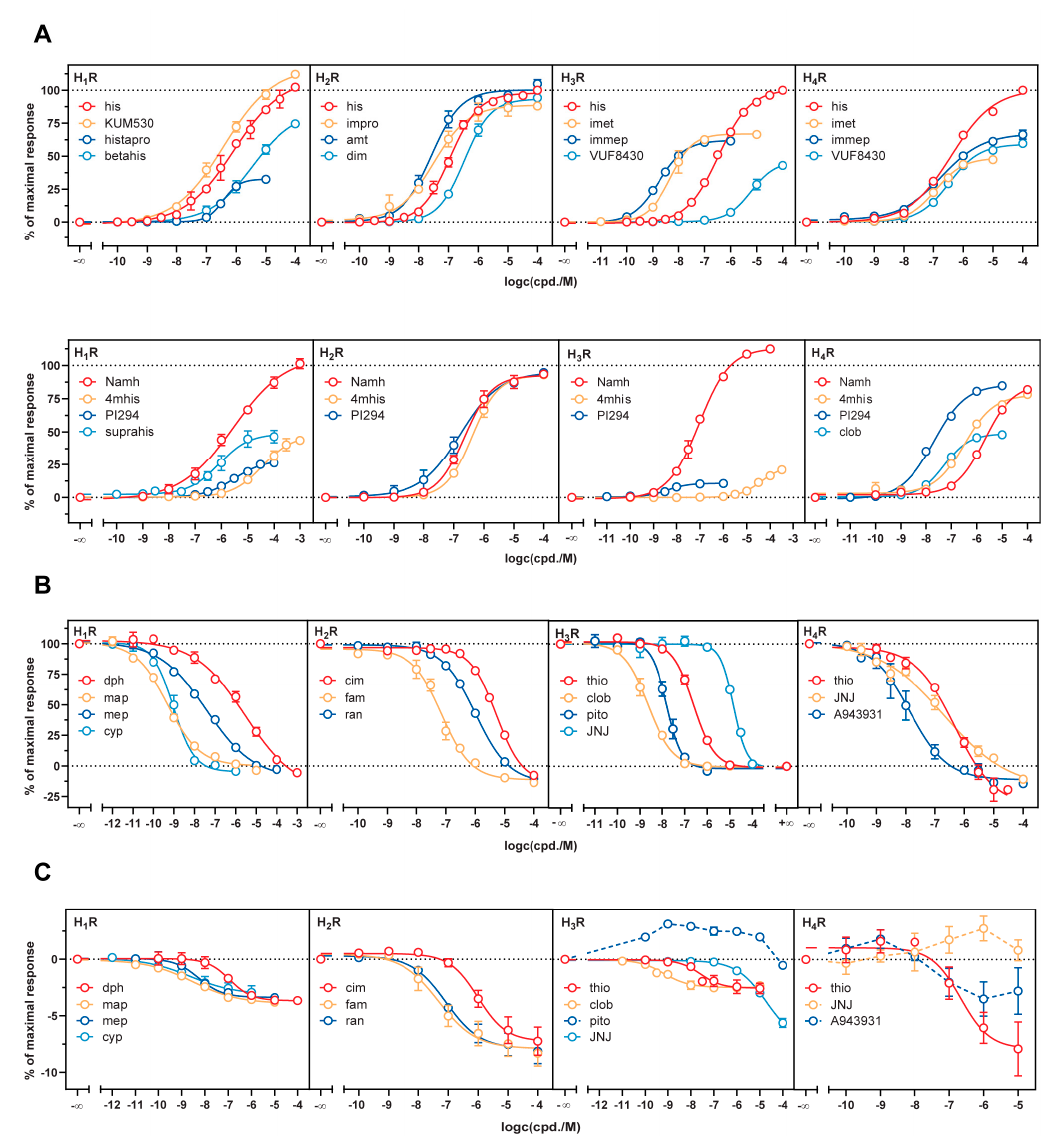
Figure 2. Concentration response curves obtained in the mini-G protein recruitment assay using agonists ( A ) in agonist mode, as well as antagonists in antagonist mode ( B ) and agonist mode ( C ). In agonist mode, the effect of the ligands themselves was tested, whereas experiments in antagonist mode were performed in the presence of the agonist histamine (H 1 R: 10 µM, H 2-4 R: 1 µM). HEK293T cells stably co-expressing a combination of either the H 1 R-NlucC/ NlucN-mGsq, H 2 R-NlucC/ NlucN-mGs, H 3 R-NlucC/ NlucN-mGsi or H 4 R-NlucC/ NlucN-mGsi were used. Data were normalized to L-15 as solvent control and to maximal responses elicited by 100 µM histamine in the case of agonists, 10 µM histamine for H 1 R antagonists or 1 µM histamine for H 2-4 R antagonists. Data represent means ± SEM from at least three independent experiments ( n ≥ 3), each performed in triplicate.